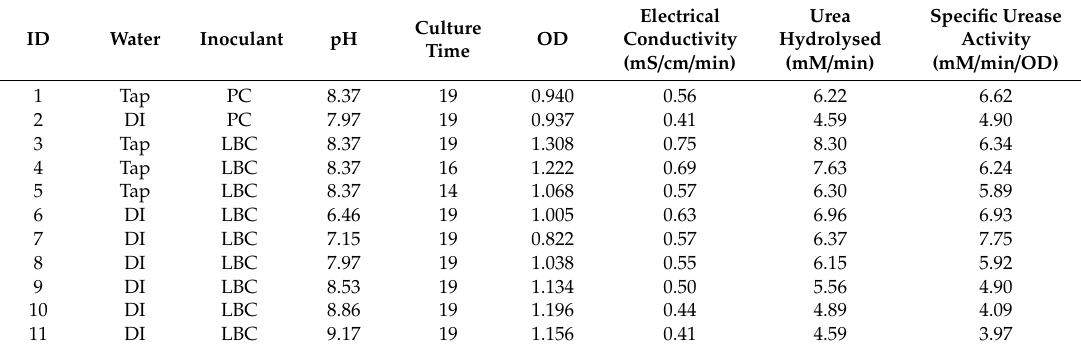
Table 5. Results from urease activity tests.